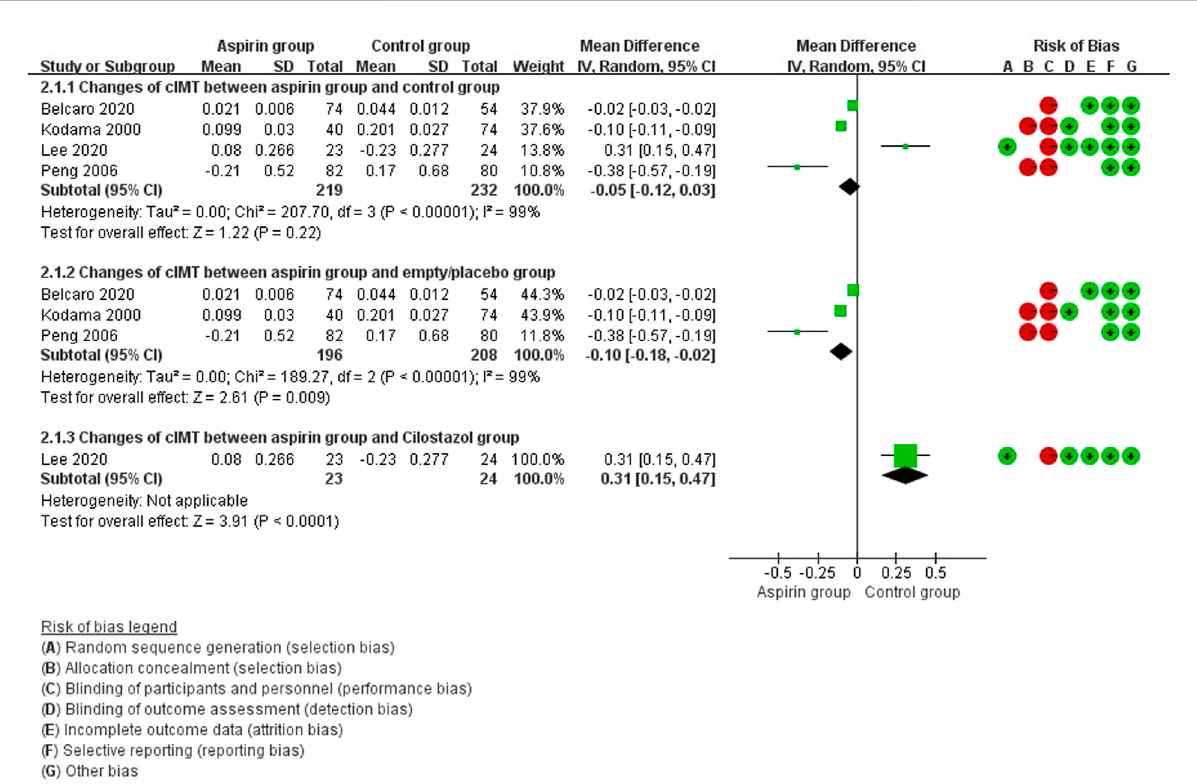
FIGURE 2 Forest plot of changes in carotid intima-media thickness (cIMT) between the aspirin group and the control group.